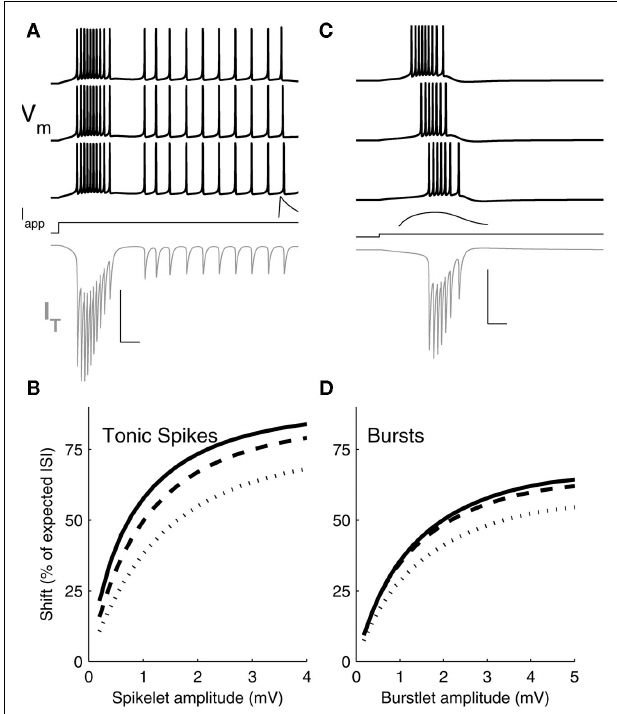
FIGURE 6 | Simulation results. (A) Three representative voltage traces (black) from a single-compartment Hodgkin–Huxley model of aTRN cell driven to spike tonically with applied DC current ( I app ) and provided with spikelet inputs of increasing amplitude (from bottom to top) preceding spikes during the regular spiking period. Spikelet shown is a response in an unstimulatedTRN cell, for a spikelet arriving 10ms before spikes in traces above. Gray trace: I T during the first (bottom) simulation. Scale bar: 25ms, 100mV ( V m ), 2mV (spikelet) 15 μ A/cm 2 ( I T ). Inset: example postsynaptic spikelet. Scale bar 10ms, 1mV. (B) Shift in arrival time of the next spike, expressed as a percent of the interspike interval (ISI) between the input and an unperturbed spike, plotted against spikelet amplitude. Results from three sets of simulations are plotted for a spikelet applied 10 (solid), 15 (dashed), or 20 (dots) ms before the unperturbed spike. (C) Voltage traces (black) of the model driven at its burst threshold by applied DC current and provided with burstlets of increasing amplitudes (bottom to top) preceding the native burst. Burstlet shown is a response in an unstimulatedTRN cell, starting 20ms before the bursts in the traces above. I T during the first (bottom) simulation is shown in gray. Scale bar: 25ms, 100mV ( V m ), 2mV (burstlet), 15 μ A/cm 2 ( I T ). Inset: example postsynaptic burstlet. Scale bar 10ms, 1mV. (D) Shift in subsequent spike times following burstlet inputs, plotted against postsynaptic burstlet amplitude. Results from three sets of simulations are plotted for a burstlet applied 20 (solid), 35 (dashed), or 50 (dots) ms before the first spike of the unperturbed